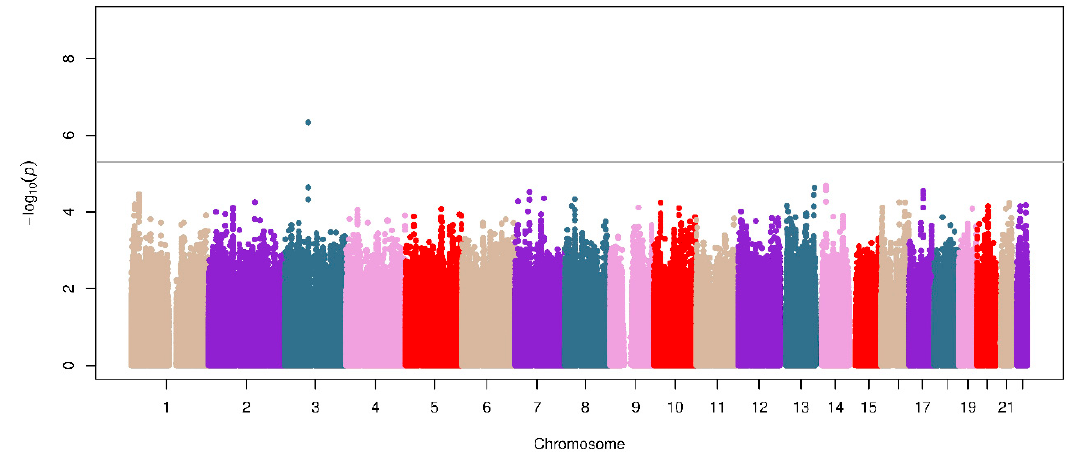
Figure 1. Manhattan plot of association results of the change in FEV 1 after ICS treatment in SLOVENIA. The logarithmic transformation of the p -value ( − log 10 p -value) is represented on the y -axis, along with the chromosome position ( x -axis). The gray line indicates the suggestive significance threshold ( p ≤ 5 × 10 − 6 ) considered for evidence of association with ICS response.